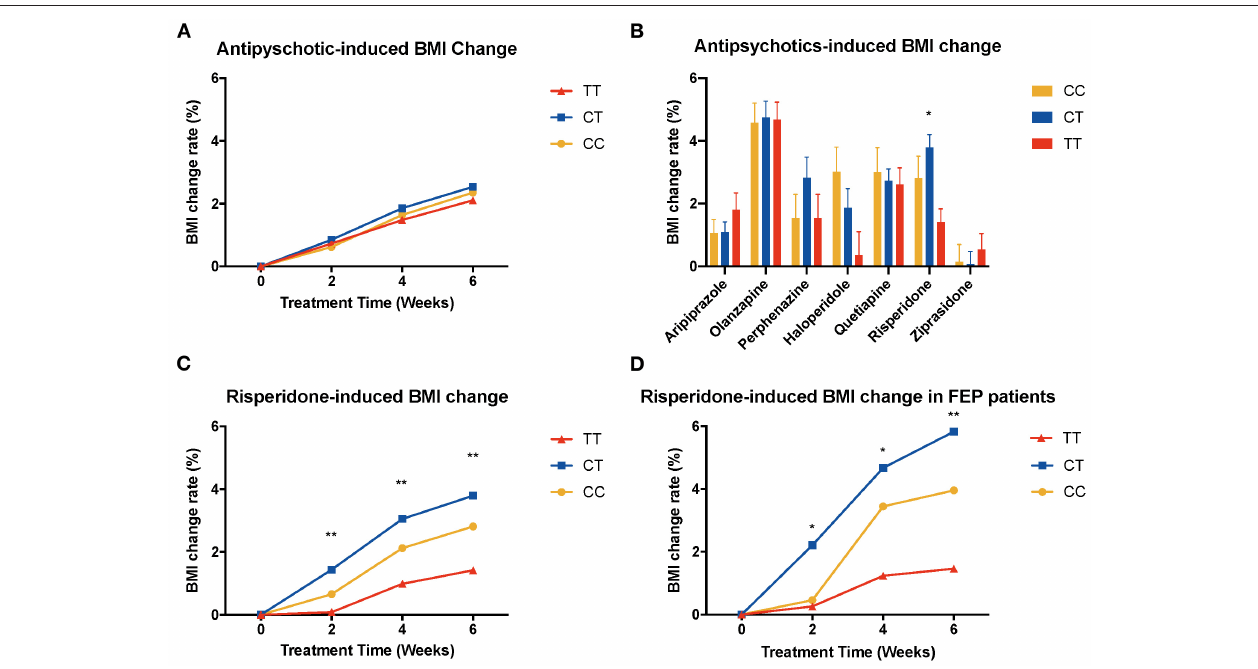
FIGURE 1 | Association of MTHFR C677T polymorphism with antipsychotic-induced weight gain in schizophrenia. BMI, body mass index; FEP patients, first-episode patients. (A) shows all the patients of different genotypes with increasing tendency; there is no significant difference between these three groups. (B) shows different kinds of drugs that induced BMI change rate after 6-week treatment, and in risperidone-treated group, these three genotypes showed significant different change rate ( F = 4.749, P = 0.009). (C) shows BMI change rate of risperidone-treated people at different time points (2 weeks, F = 5.488, p = 0.005; 4 weeks, F = 5.981, P = 0.003; 6 weeks, F = 4.749, P = 0.009). (D) shows the same pattern in first-episode people (2 weeks, F = 3.636, P = 0.030; 4 weeks, F = 4.066, P = 0.021; 6 weeks, F = 4.157, P = 0.019).